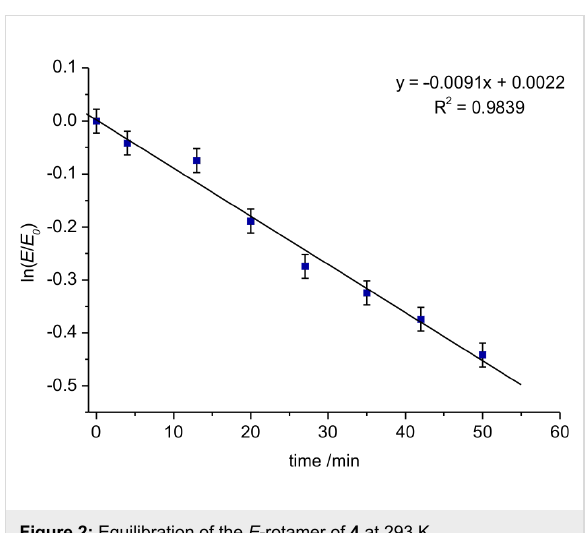
between the well separated peaks of the Z - and E -rotamers (first and later eluted isomer, respectively), indicating the intercon- version during the partitioning process (Figure 3).